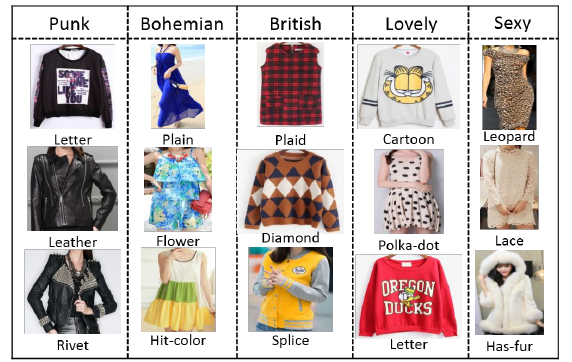
Figure 4: The illustration of clothing styles and fashion at- tributes